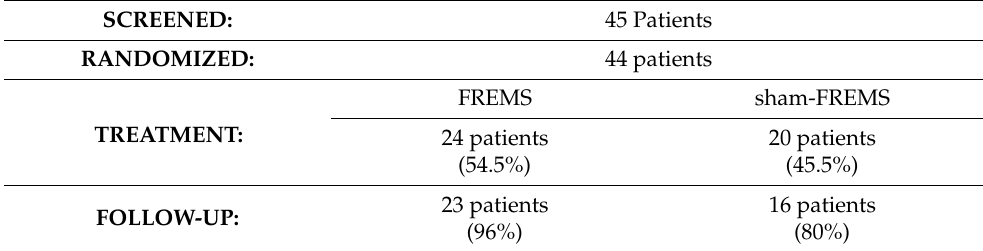
Table 1. Flow diagram of the